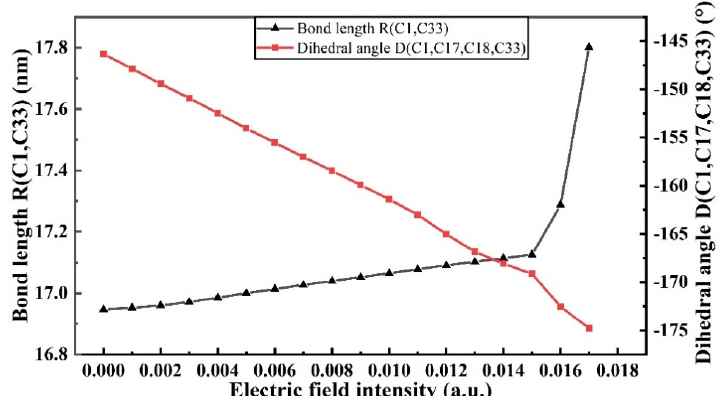
Polymers 2023 , 15 , x FOR PEER REVIEW Figure 5. Changes in bond length and dihedral angle of PVDF molecules. Figure 5. Changes in bond length and dihedral angle of PVDF molecules.